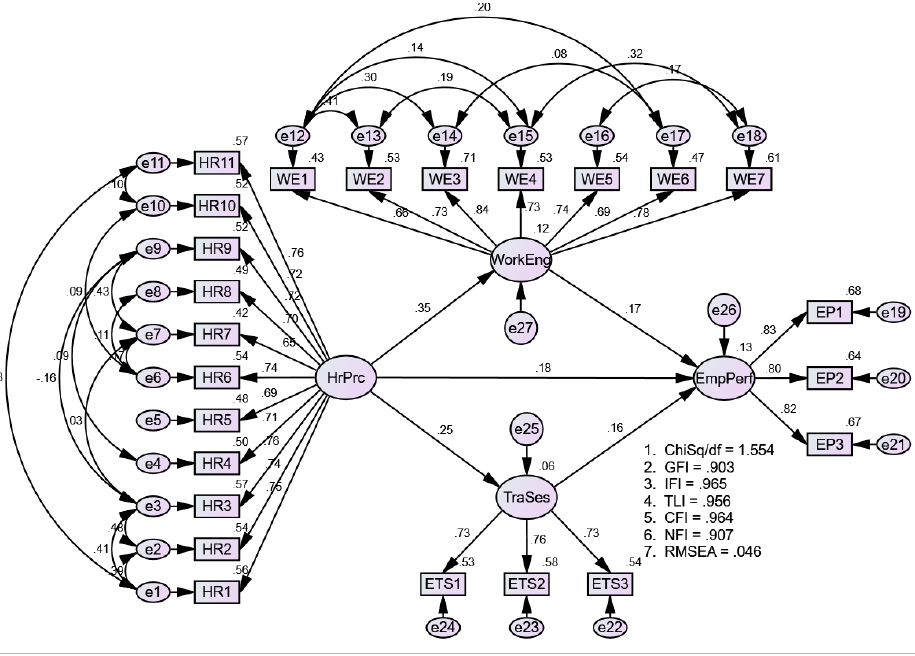
Figure 3: Structural Equation